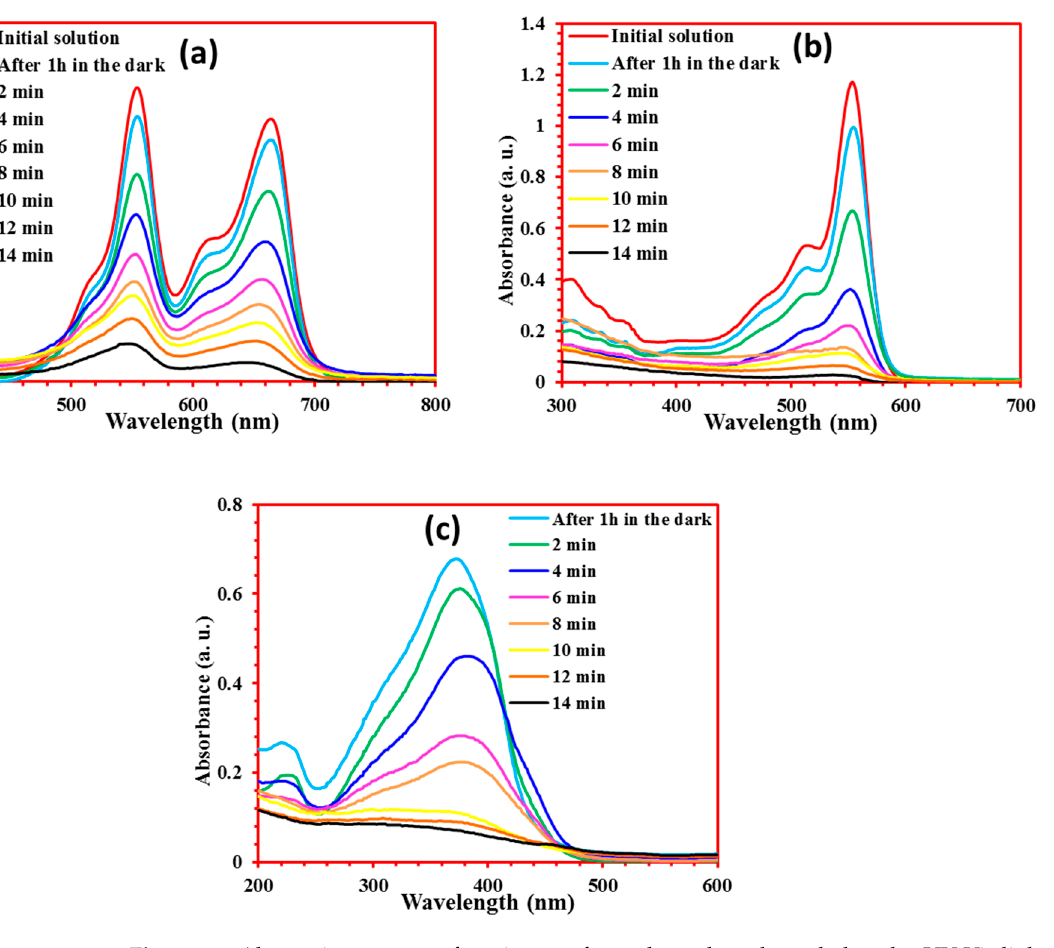
Figure 13. Absorption spectra of a mixture of two dyes photodegraded under UV-Vis light in the presence of BiP-500 photocatalyst: ( a ) RhB + MB, ( b ) RhB + OG and ( c ) MO + OG.